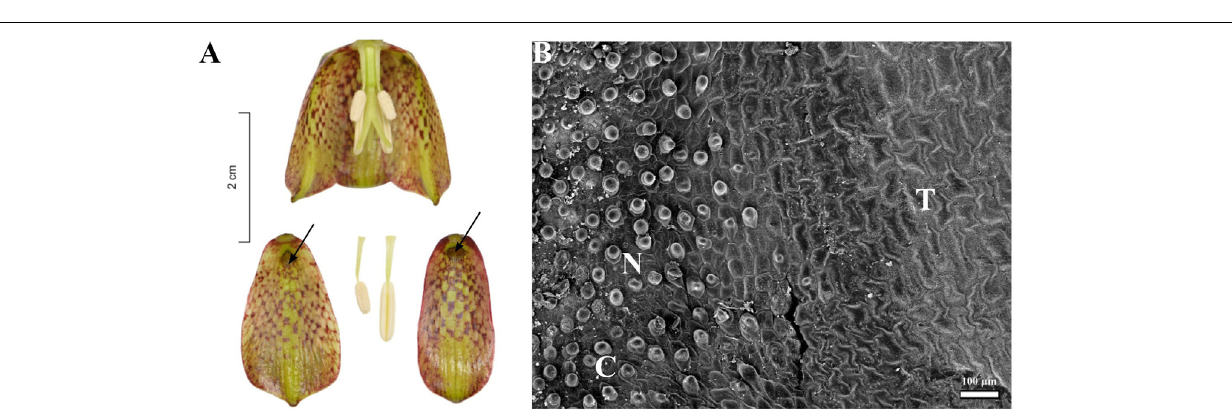
FIGURE 5 | Flowers and nectaries of F. pyrenaica . Macro and SEM images. (A) Flowers and tepals, nectaries marked with arrows. (B) Part of outer tepal showing the nectary area (N), comprising conical papillae and slightly convex cells (C) of surrounding tepals area